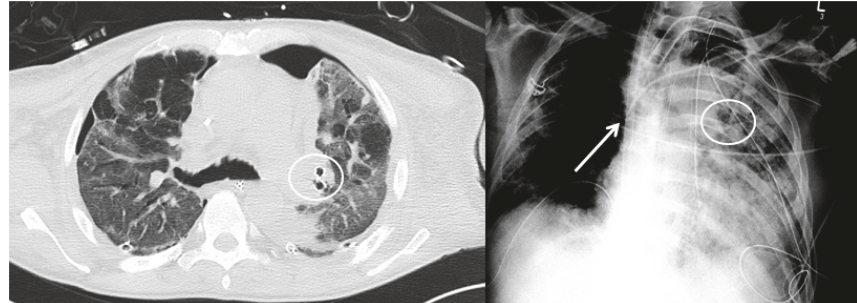
Figure 2: CT-scan (left image) and chest X-ray (right image) after endobronchial valve placement. The left lung is again fully expanded. The circled areas depict the two endobronchial valves within the left upper lobe segmental bronchi (LB1/2 and LB3). The Avalon Elite (cid:2) Bi-Caval Dual Lumen Catheter is visible on the chest X-ray (white arrow).